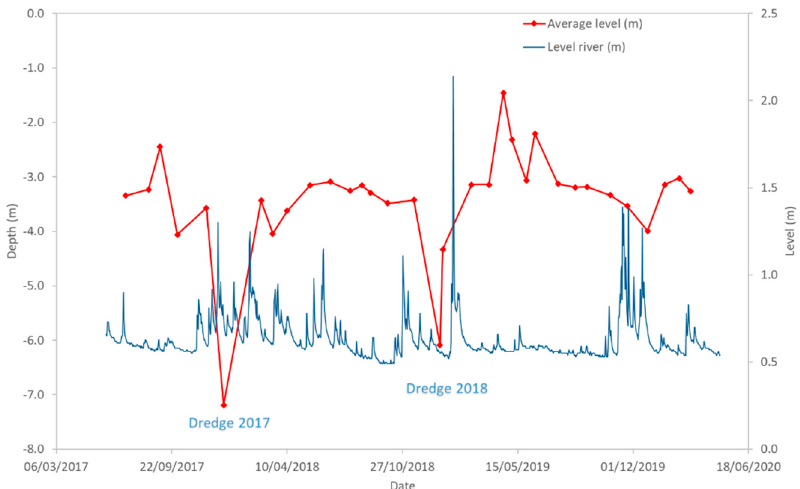
Figure 10. Effect of the Negro River on the average level of the dock in the Port of Luarca.